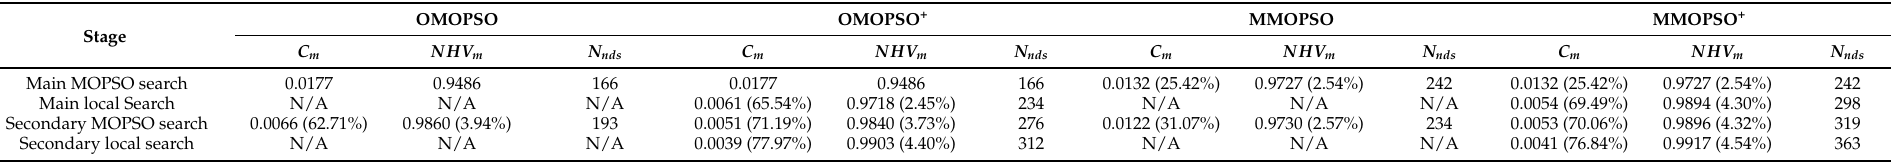
Table 3. Values of C m , NHV m , and N nds for the final PFs in HAN (relative improvements in C m and NHV m with respect to the main MOPSO search stage of OMOPSO are in brackets.)